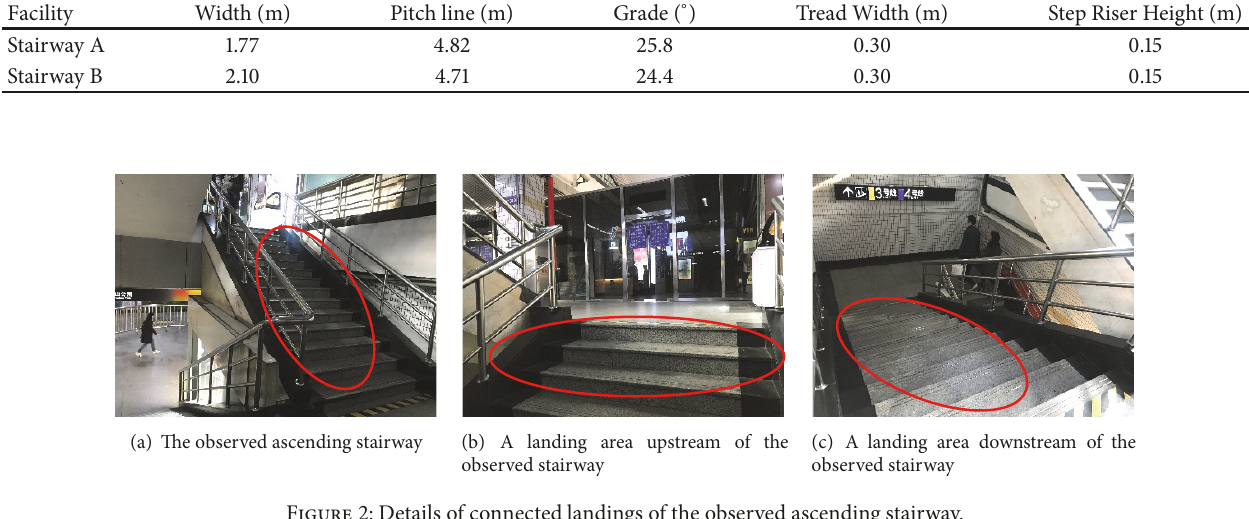
Figure 2: Details of connected landings of the observed ascending